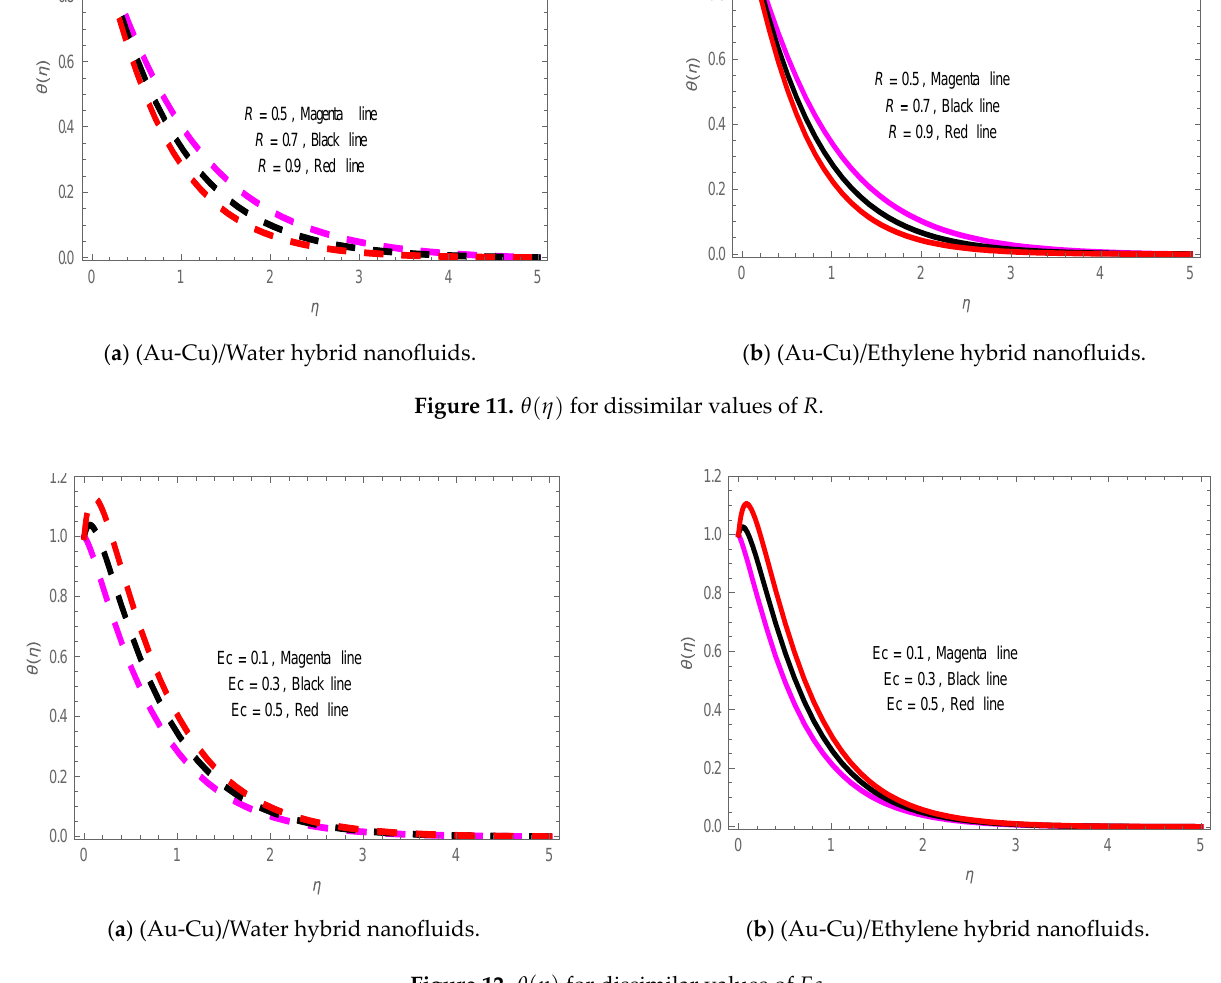
Figure 12. 𝜃(𝜂) for dissimilar values of Ec.